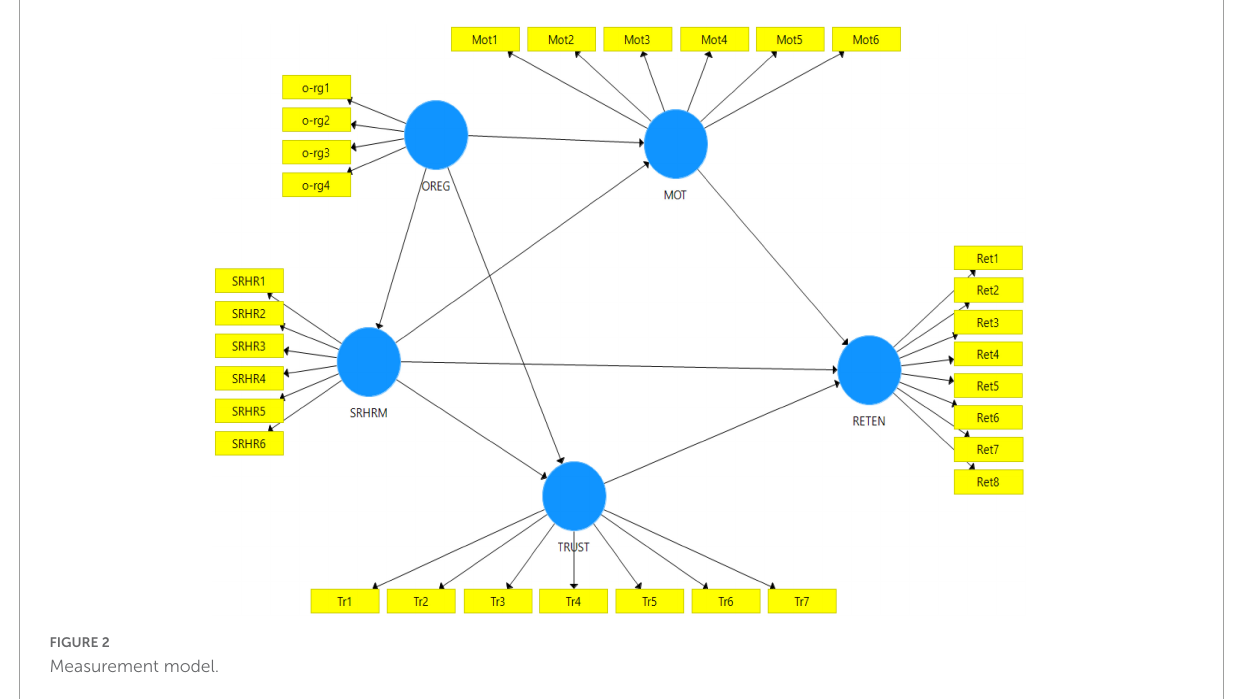
FIGURE2 Measurement model.